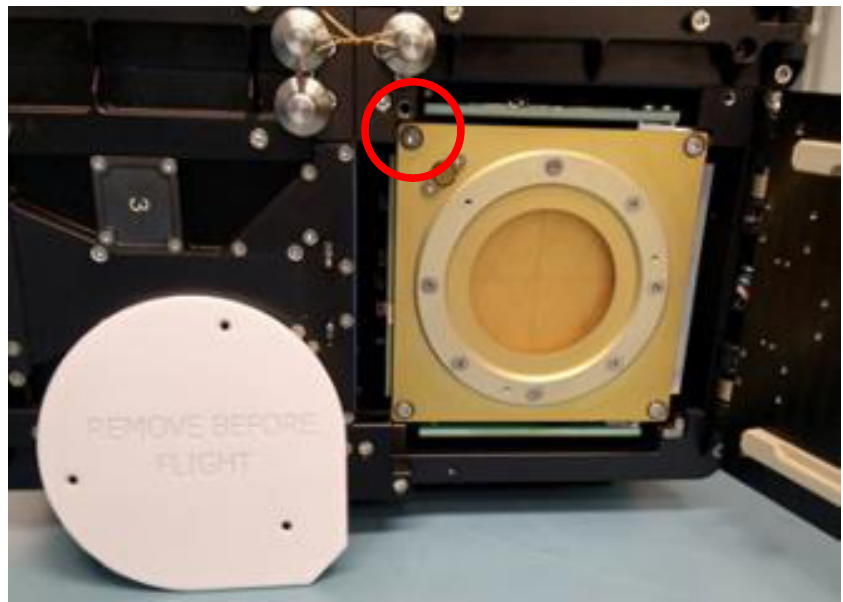
Figure 16. Orientation of IDEASSat when inserted into the QuadPack. Dynamic rail position indicated by red circle.